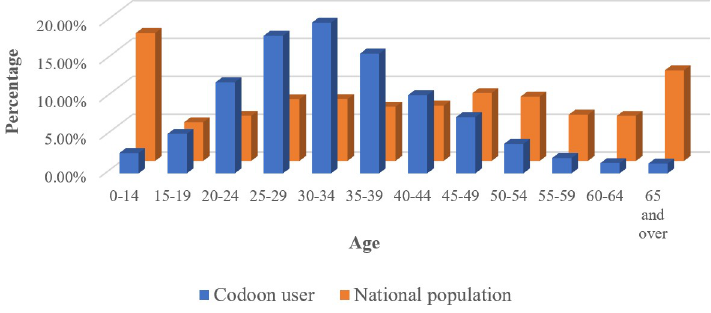
Fig 2. Age composition of Codoon users and the national population in